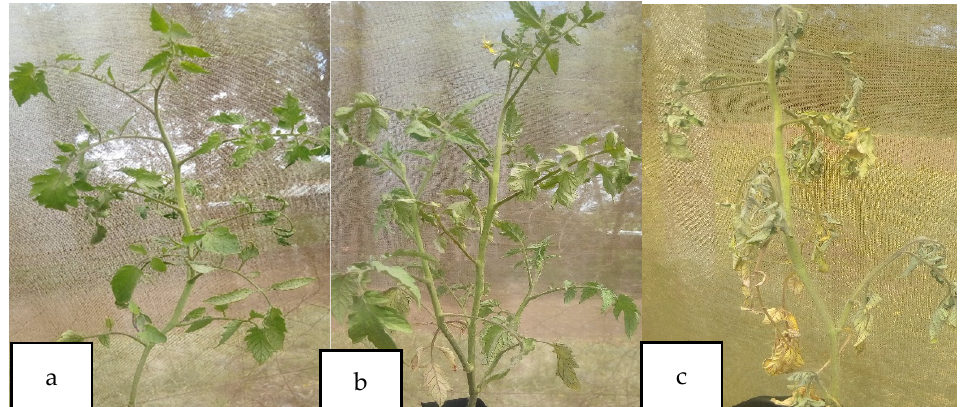
Figure 4. Wilting symptoms in ( a ) BSF-based pupal exuviae chitosan treated plant, ( b ) BSF-based pupal exuviae chitin treated plant, and ( c ) non-treated plant.